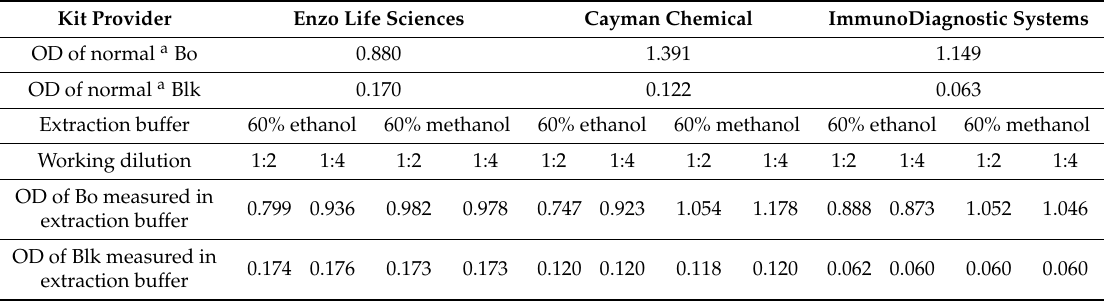
Table 3. Mean optical density (OD) values ( n = 3) of EIA dynamic range key parameters (Bo and Blk) in both extraction buffers for each tested commercial